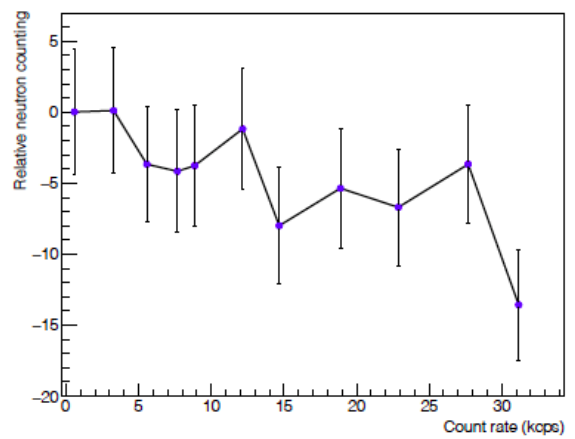
Figure 6: The relative neutron counting as a function of the total counting rate. 3) Comparative results of Red Pitaya and CAEN digitizer with plastic scintillator EJ276.